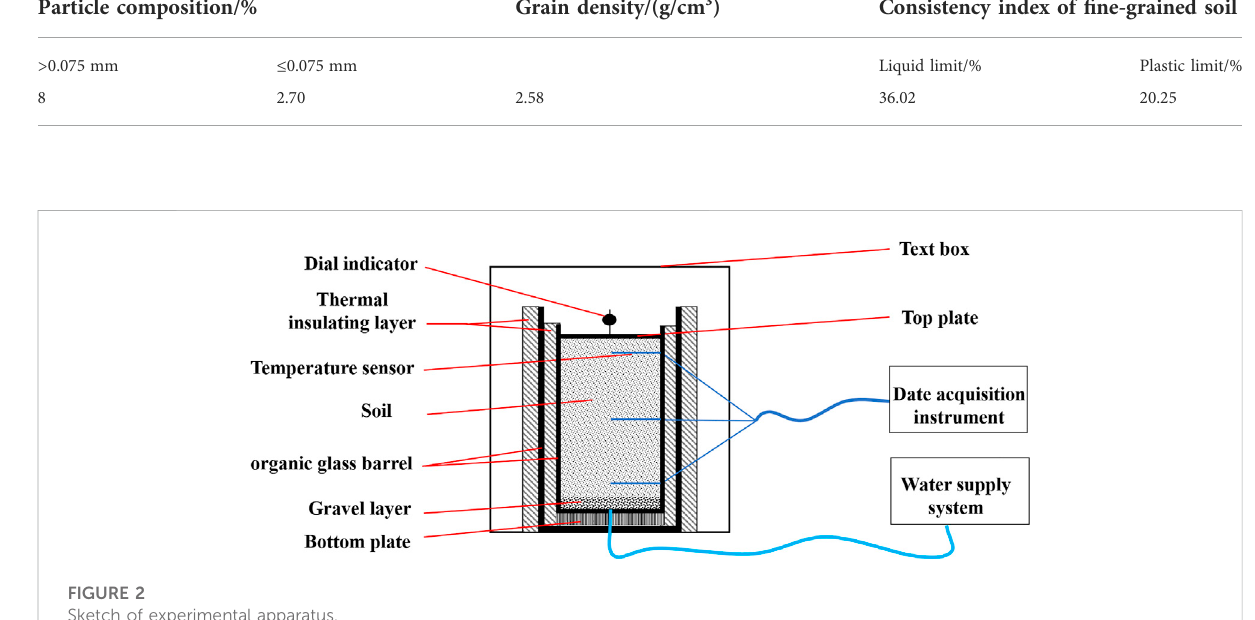
FIGURE 2 Sketch of experimental apparatus.